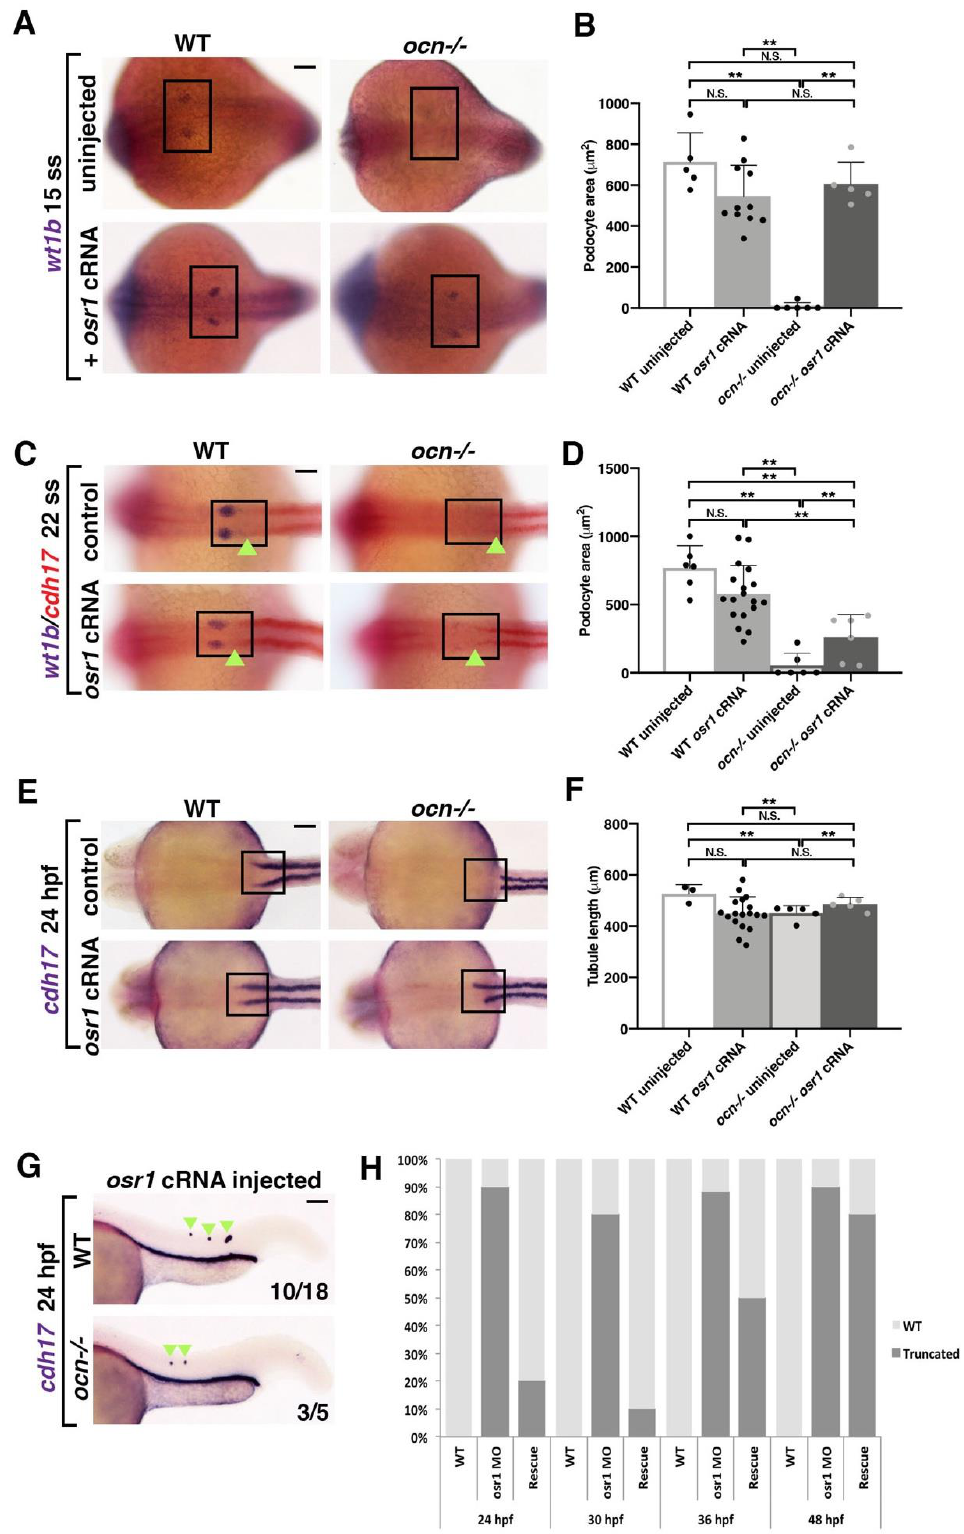
Figure 3. osr1 is required for the continued development of kidney lineages. ( A , B ) Embryos from ocn incrosses were injected at the 1-cell stage with 50 pgs of osr1 cRNA and examined. At 15 ss, podocytes ( wt1b ) were robustly rescued in ocn − / − . ( C,D ) However, by 22 ss, podocytes were only partially rescued in ocn − / − injected embryos, while tubule lengths in the same animals were not significantly different from WTs, as shown by the green arrowheads. ( E – G ) Truncated tubule was still able to